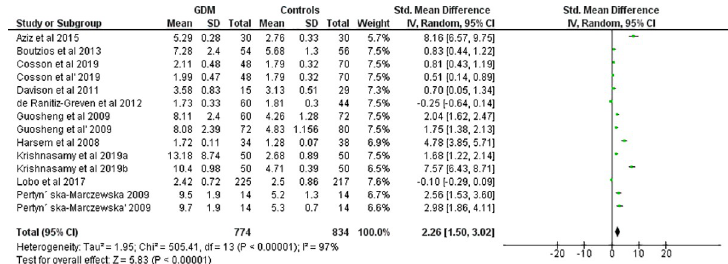
Fig 2. Forest plot depicting the mean level (U/ml) of AGEs in GDM and pregnant controls.